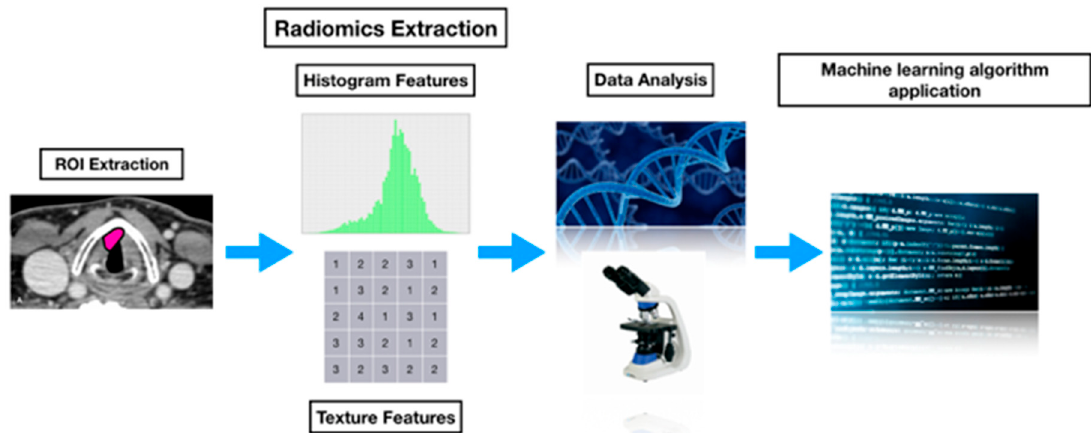
Figure 2. Radiomics analysis workflow. Image segmentation is performed on computed tomography (CT) images. Experienced radiologists delineate the volume of interest covering the whole tumor by stacking up the region of interest slice by slice. Radiomics features are extracted including shape- and size-based features, first-order histogram features, and textural features. The data are analyzed, and clinical application is tested.